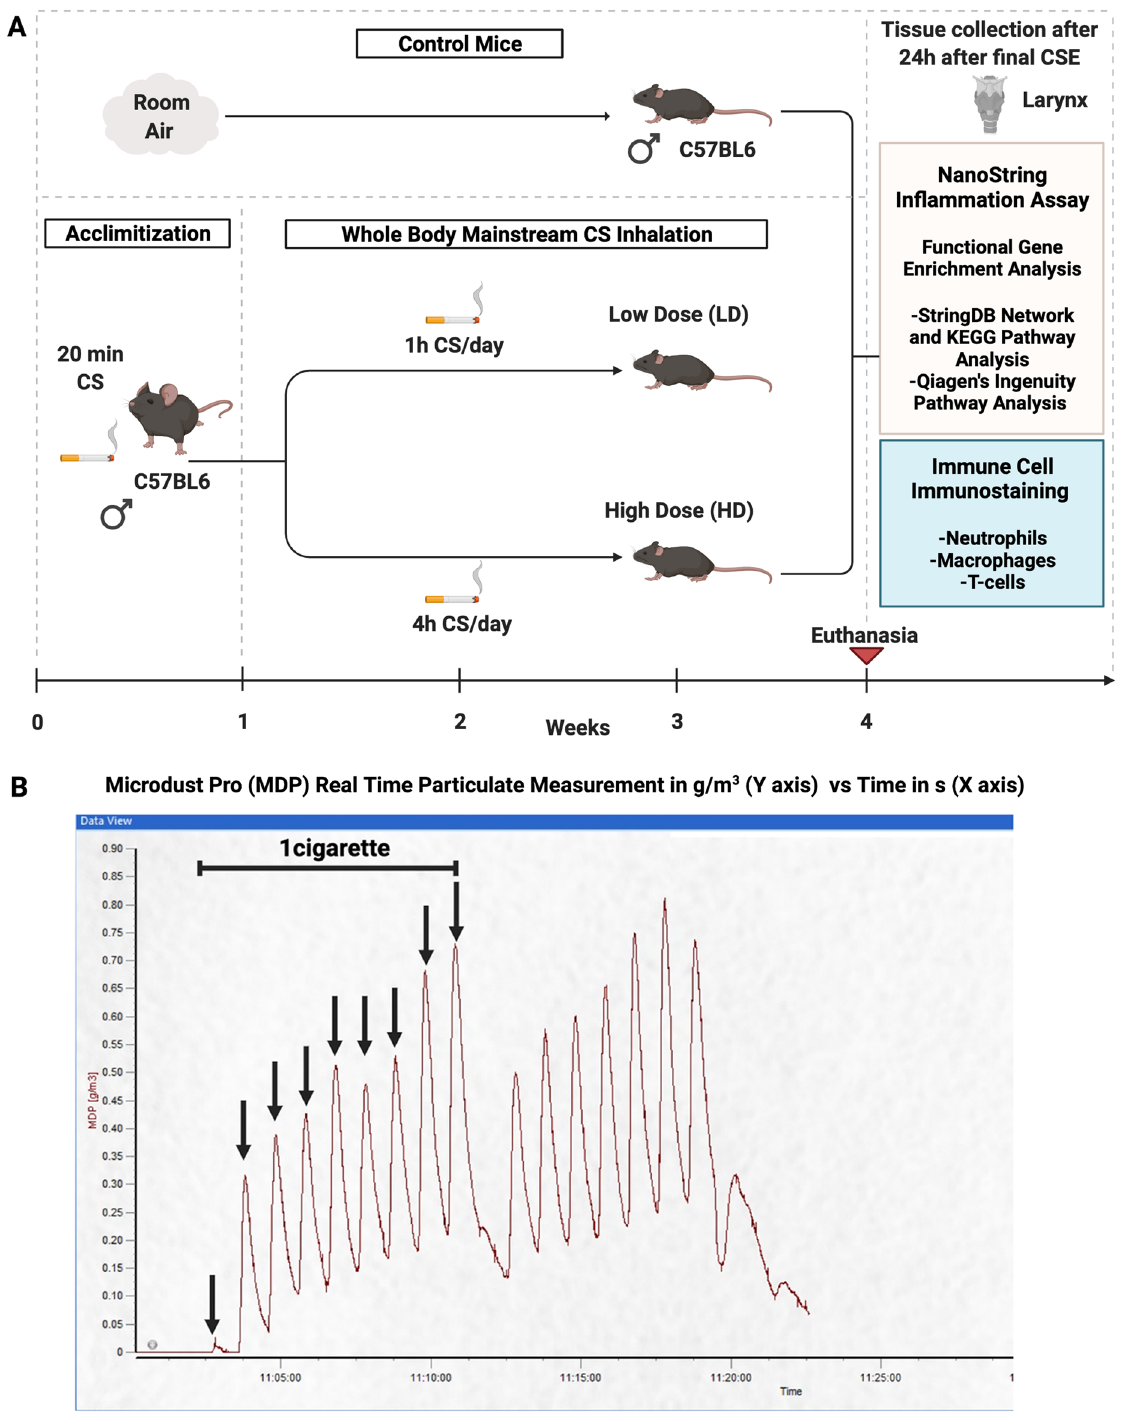
Figure 8. Experimental design. Adult male C57Bl/6 were assigned to control, low dose (LD), and high dose (HD) groups ( A ). Control mice were air exposed. LD and HD mice were exposed to 1 h and 4 h of cigarette smoke (CS) per day respectively, for a total of 4 weeks, 5 days/week. LD and HD mice were acclimated to 20 min of CS per day for a week prior to the start of exposures. Laryngeal tissues were harvested 24 h after the final CS exposure (CSE) at week 4 for NanoString analysis and associated network and pathway-based functional gene enrichment analysis. Harvested larynges were also processed for immunohistochemical staining. CS exposures were monitored in real-time by using a probe, Microdust Pro ( B ). Each recorded peak represents a puff and a total of 9 puffs were recorded per 3R4F